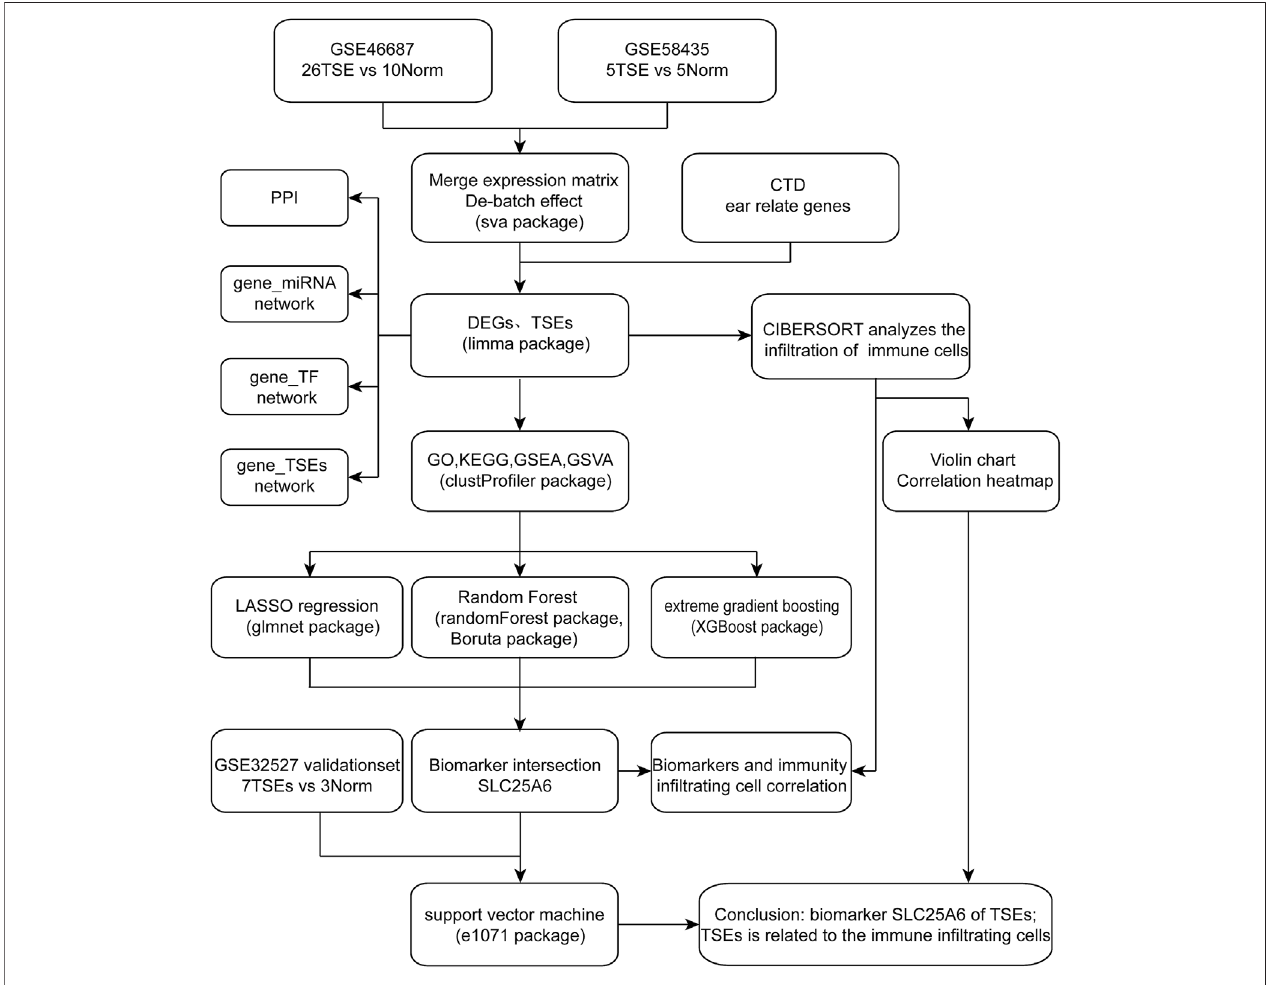
FIGURE 1 | Research fl ow